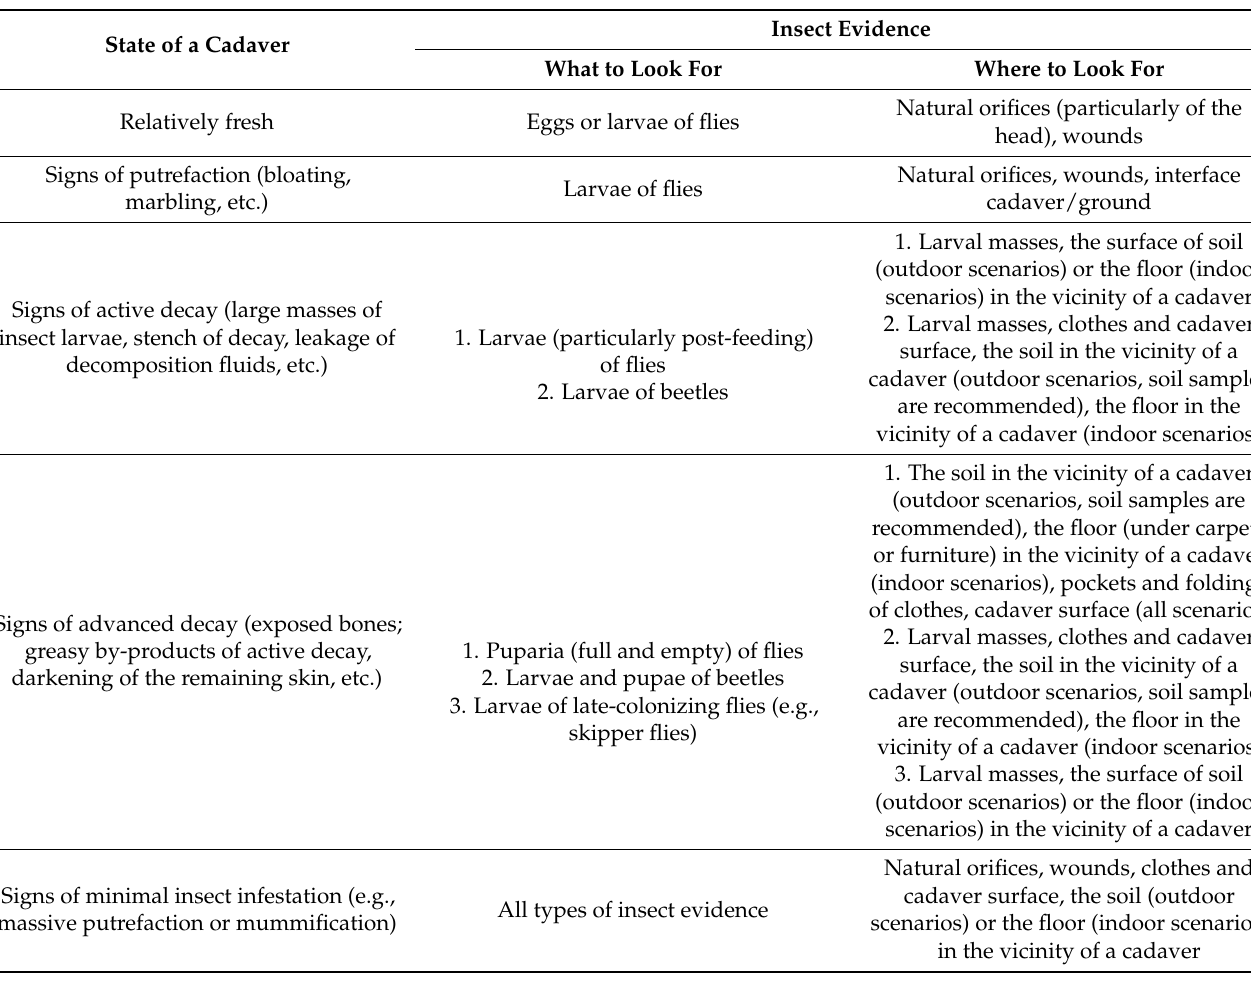
Table 1. A sketch of guidelines for the collection of insect evidence on a death scene. To make them useful to non- entomologists, they should be combined with pictures of insect evidence and protocols suitable for the preservation of particular pieces of